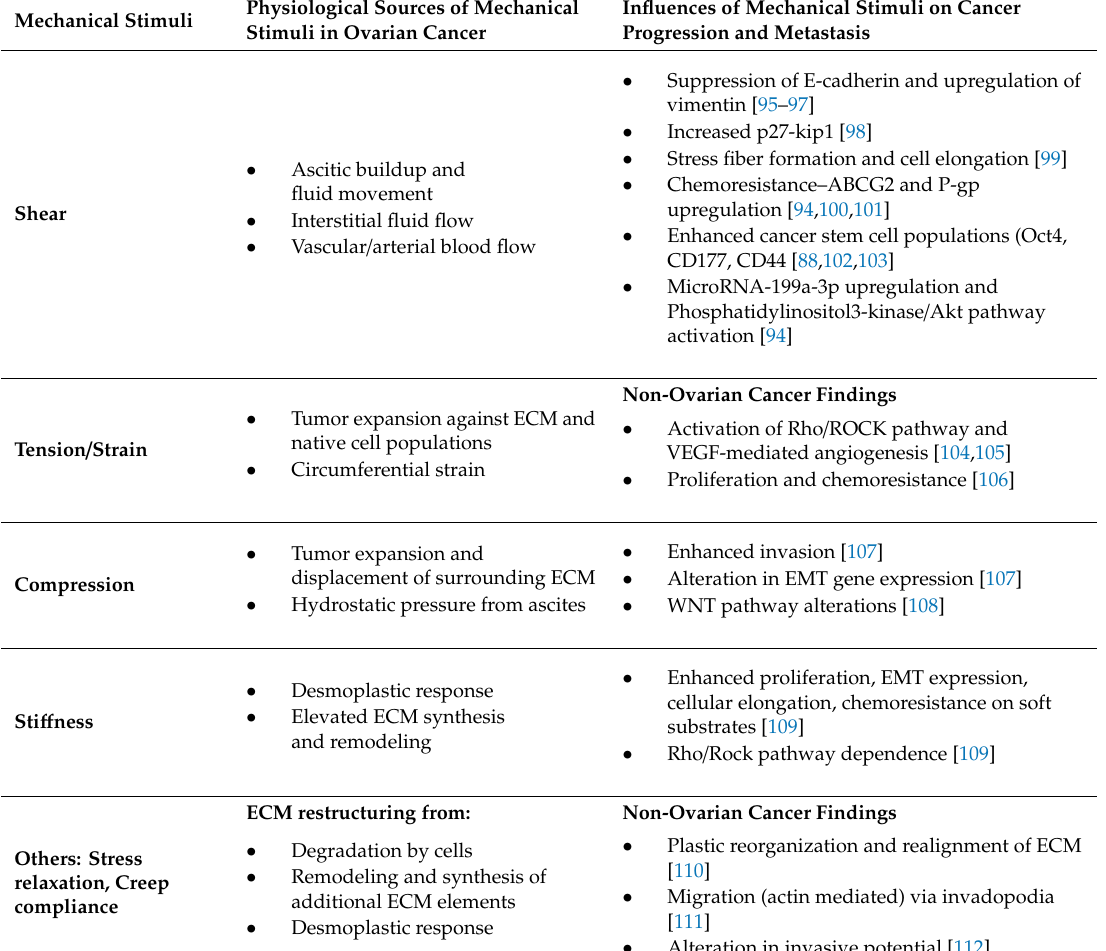
Table 1. Summary of studies on mechanical stimulation in ovarian cancers and consequences on metastasis and cancer